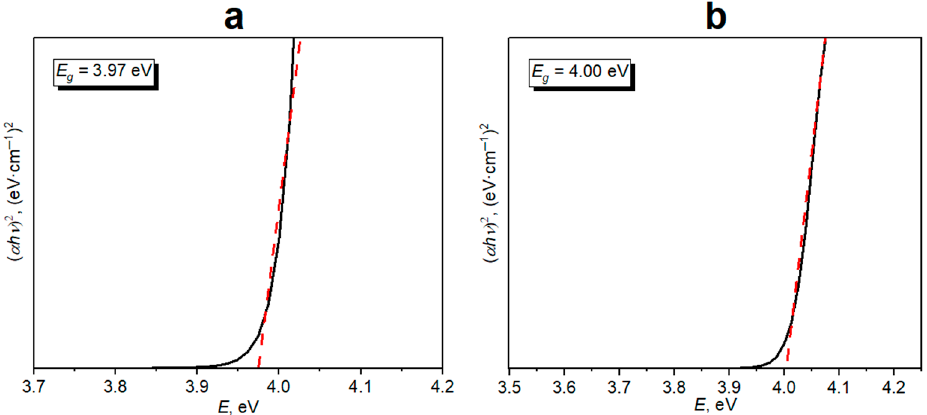
Figure 3. Tauc’s plots for band gap determination of [Eu(BDCA) 2 (H 2 O)]Cl 3 ( a ) and [Tb(BDCA) 2 (H 2 O)]Cl 3 ( b ).